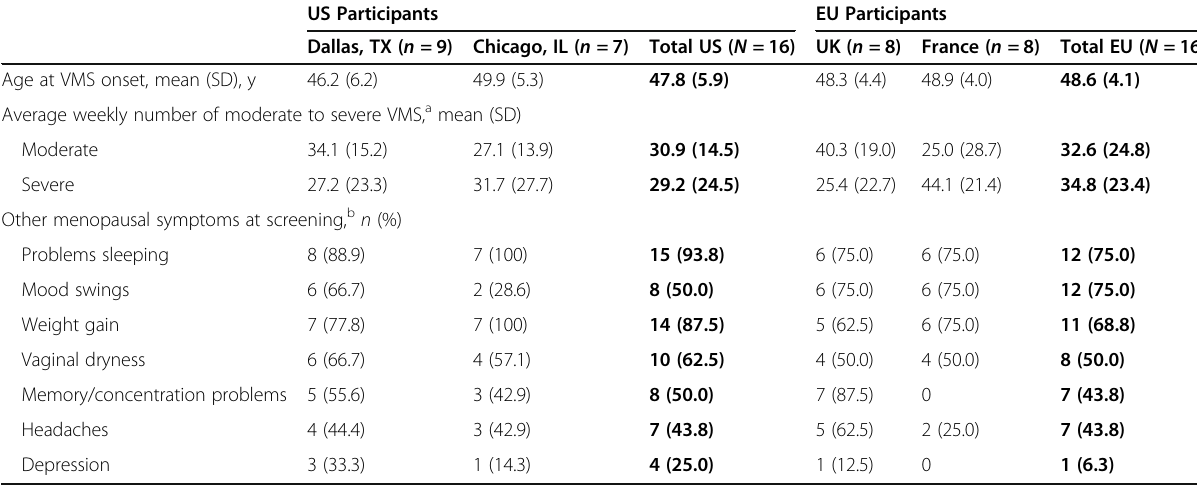
Table 4 Menopausal symptoms reported at screening US Participants